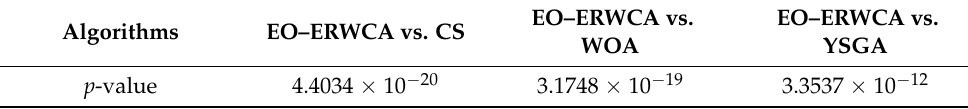
Table 4. p -Values obtained with Wilcoxon’s rank-sum Table 4. p -values obtained with Wilcoxon’s rank-sum test.